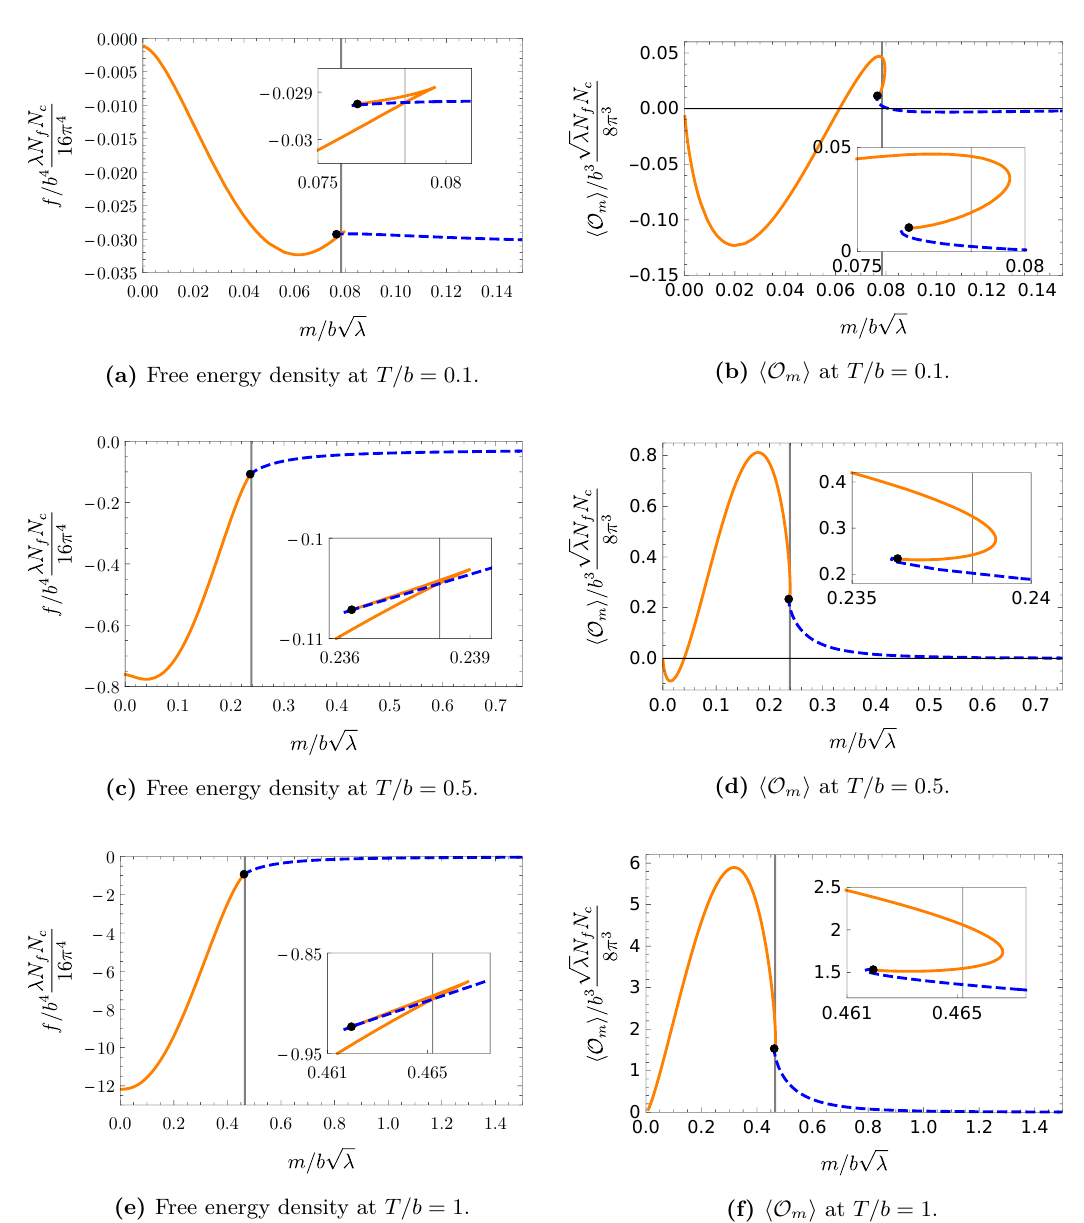
√ λN f N c ) and for hO m i / ( b 3 ) 16 π 4 8 π 3 √ λ ) at